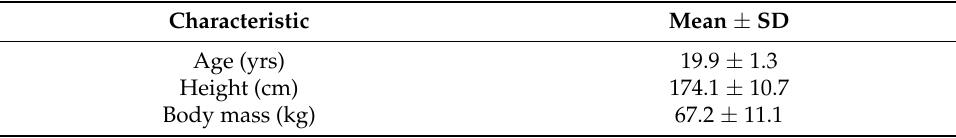
Table 1. Descriptive characteristics ( n =